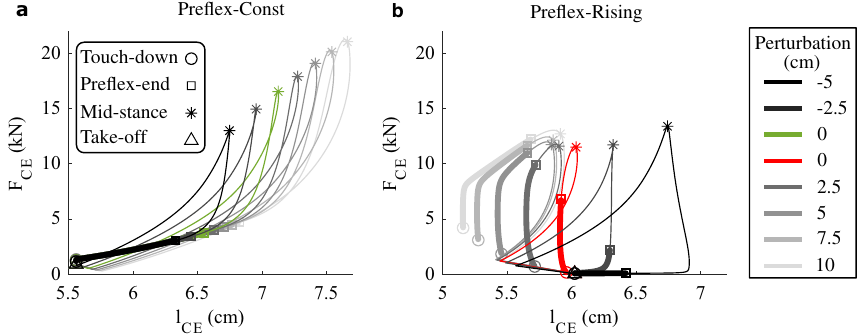
Figure 3. Muscle fibre workloop results for ( a ) Preflex-Const and ( b ) Preflex-Rising. Data is plotted from touch-down (open circle) to take-off (open triangle). The preflex phase is emphasised with thicker lines. Open squares indicate the end of the preflex duration, asterisks indicate mid-stance. The drop height increases from darker to lighter colors: the darkest and lightest workloops are produced by the largest step-up and step-down perturbations, respectively. Reference hopping conditions are coloured green and red for Preflex-Const and Preflex-Rising, respectively.